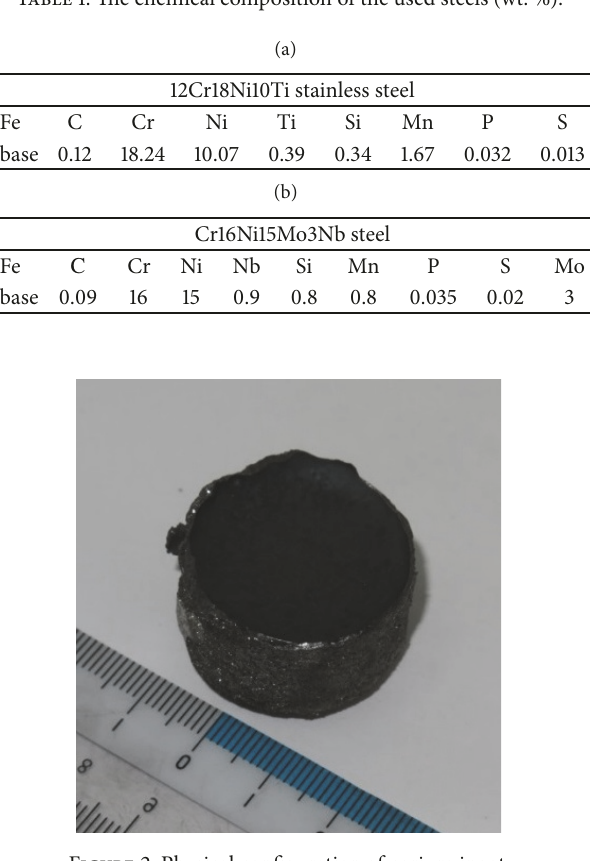
Figure 2: Physical configuration of corium